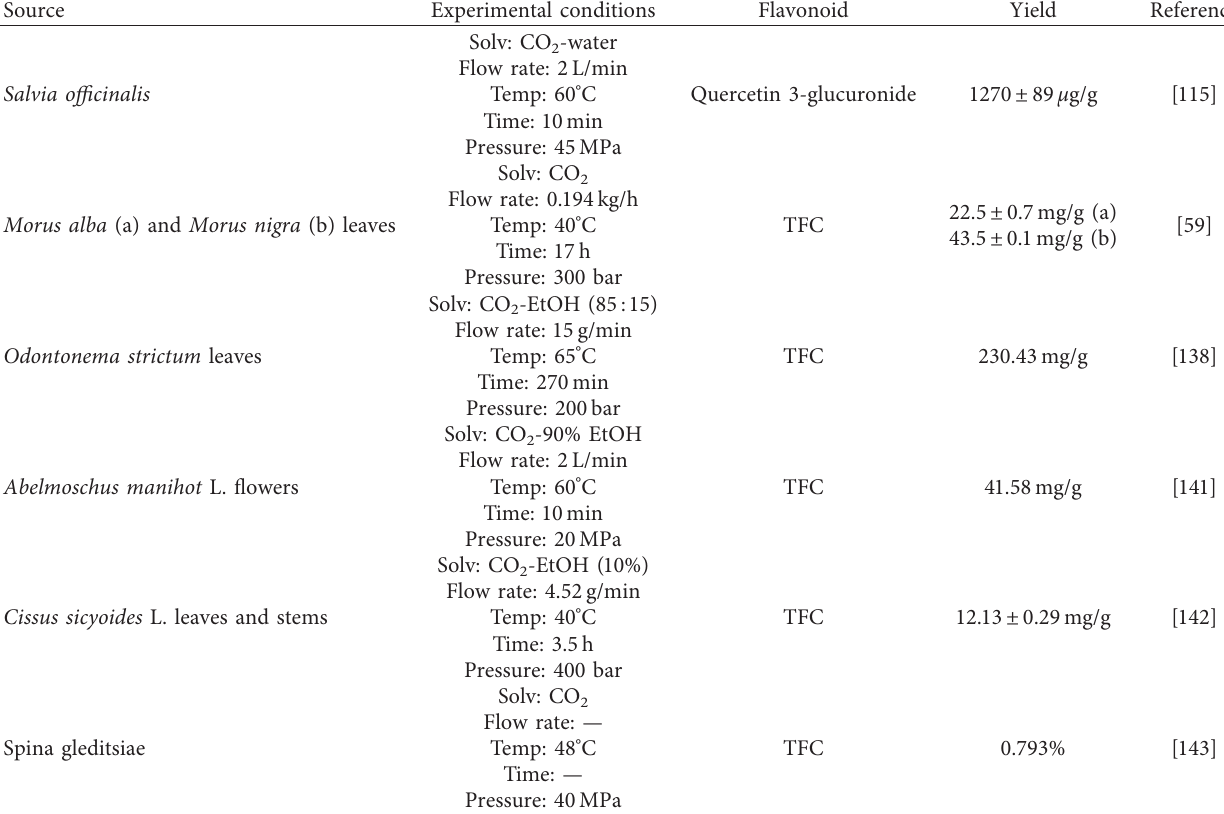
Table 4: Experimental conditions for supercritical fluid extraction of